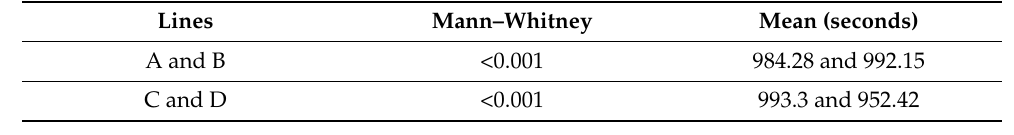
Table 3. Results of Mann–Whitney test.